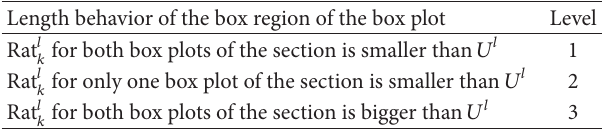
Table 1: Summary of the first phase of the section classifying algo- rithm.